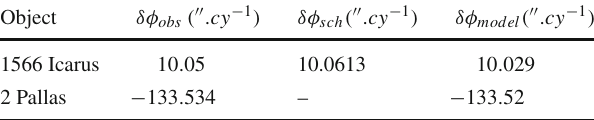
Table 2 Comparison between the observational values δφ obs for sec- ular precession in units of arcsec/century and the values from the stan- dard (Einstein) perihelion precession and the Zipoy solution δφ model for selected asteroid 1566 Icarus and